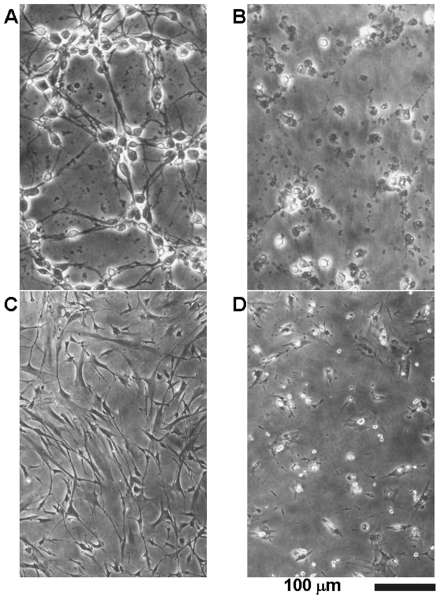
15d-PGJ2 induced morphorogical degeneration in cortical neurons and BSMC.Cortical neurons (A and B) and BSMC (C and D) were treated with vehicle (A and C) or 10 µM 15d-PGJ2 (B and D). Vehicle was 0.1% ethanol. Cortical neurons and BSMC were examined by phase-contrast microscopy 24 h and 48 h later, respectively.